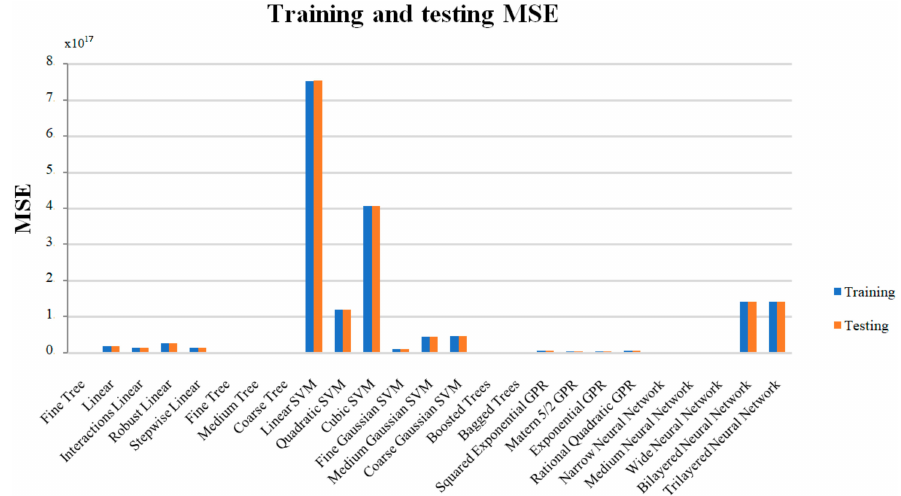
Figure 5. Training and testing MSE.